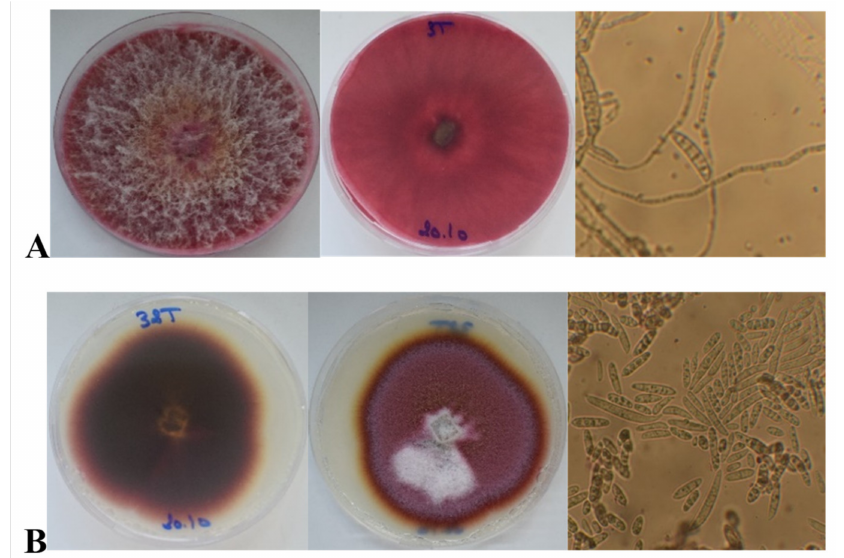
Figure 1. Morphological characteristics of Fusarium sp. isolated from asymptomatic Tunisian durum wheat grains. Observation of mycelial colonies and macroconidia grown on PDA. ( A ) 3T isolate representing the first morphotype after incubation at 25 ◦ C for 7 days. ( B ) 32T isolate representing the second morphotype, after incubation at 25 ◦ C for 11 days. Spores were observed under an optical stereomicroscope (Magnification 2000 ×